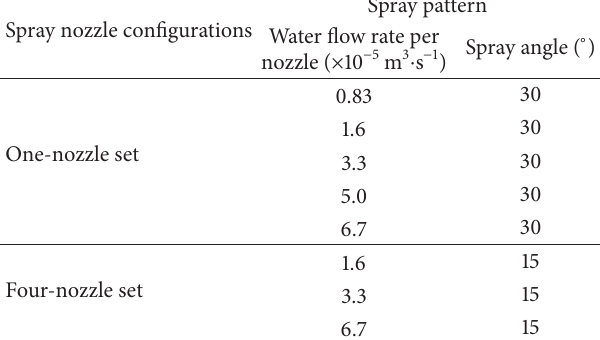
Table 1: Spray nozzles main characteristics.